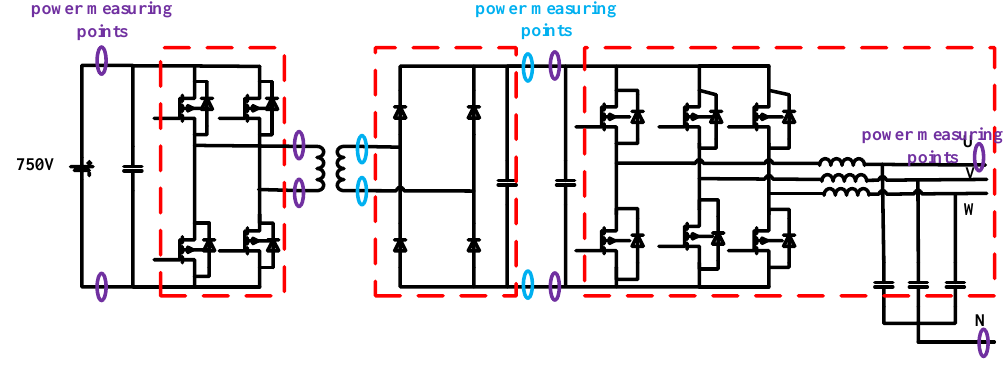
Figure 18. Position of power measuring points.